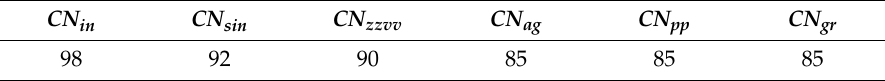
Table 5. Curve Numbers ( CN s) of each land use, porous pavement and green